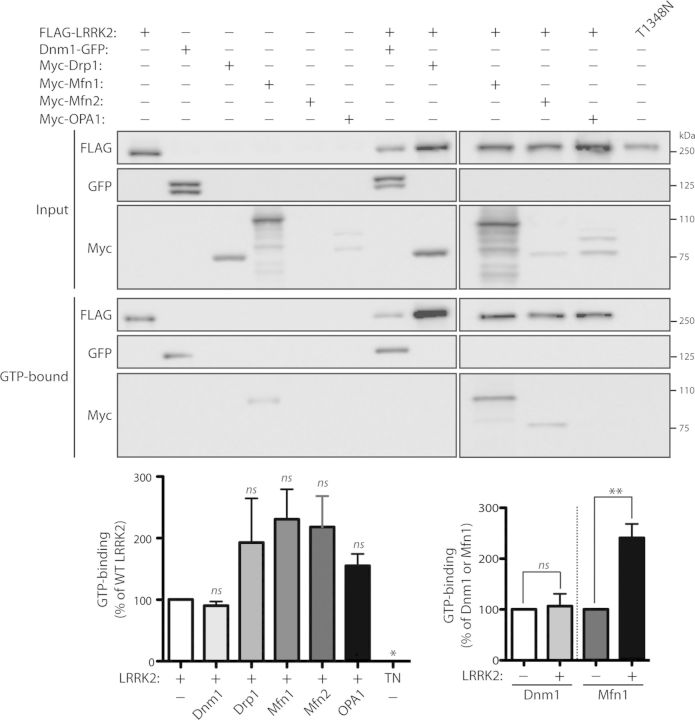
LRRK2 enhances the levels of GTP-bound Mfn1. Dynamin GTPases (Dnm1, Drp1, Mfn1, Mfn2 and OPA1) fail to significantly influence the steady-state levels of FLAG-tagged WT LRRK2 bound to GTP following pull-down assays with GTP-agarose from HEK-293T cell extracts. The specificity of LRRK2 GTP binding is indicated by the absence of binding of the GDP/GTP-binding-deficient LRRK2 mutant, T1348N (TN). Densitometric analysis reveals significantly enhanced steady-state levels of Mfn1 but not Dnm1 bound to GTP in the presence of LRRK2. Note that only Mfn1 and Dnm1 reveal detectable GTP binding when expressed alone compared with Drp1, Mfn2 and OPA1. Molecular mass markers are indicated in kDa. Data represent the level of LRRK2 (left) or Dnm1 and Mfn1 (right) GTP binding expressed as a percent of the levels of each protein alone. GTP-bound protein levels were normalized to input protein levels. Bars represent the mean ± SEM (n = 3 experiments). *P < 0.05 or **P < 0.002 by one-way ANOVA with Newman–Keuls post hoc analysis, as indicated. n.s., non-significant.